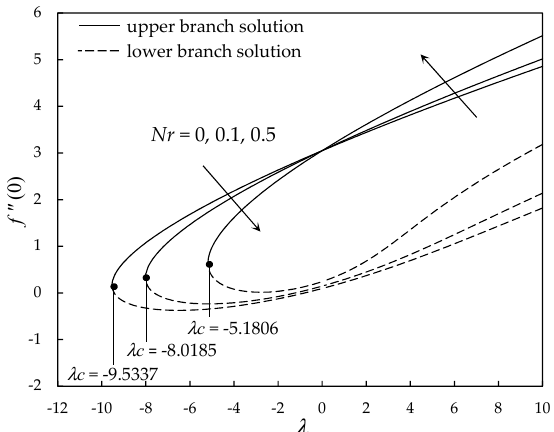
10 of 22 Figure 3. Variation of the reduced local Nusselt number − 𝜃 (cid:4593) (0) with the mixed convection parameter 𝜆 for several values of the volume fraction of nanoparticles 𝜙 when Nr = 0.1, K = − 0.1, c = − 1 and s = 1 for Cu-water nanofluid. Figures 4 and 5 display the impacts of the thermal radiation parameter Nr on 𝑓 (cid:4593)(cid:4593) (0) and −𝜃′(0) , respectively. Figure 4 also illustrates that the reduced skin friction coefficient increases as Nr is reduced in the case of the opposing flow. The reverse trend is noted in the event of the assisting flow and an increment in thermal radiation enhances the transmission of energy between the nanoparticles on a heated surface (assisting flow). Eventually, the thickness of the momentum boundary layer becomes thinner and increases the wall shear stress which raise the values of 𝑓 (cid:4593)(cid:4593) (0) . The decrement trend in the rate of heat transfer at the surface leads to an increment in the thermal